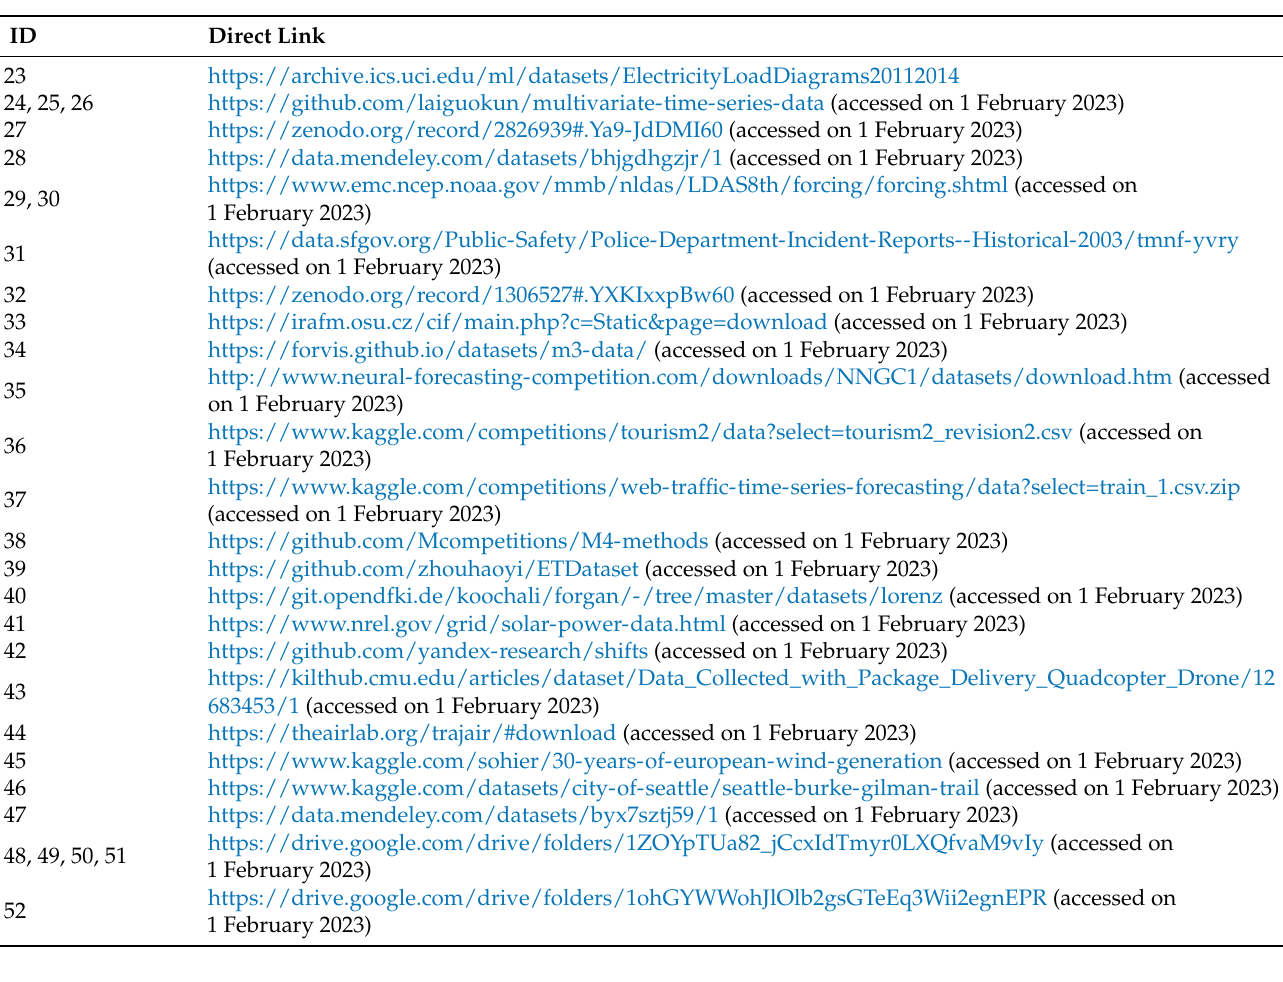
Table 4. A general overview of the public datasets found through the paper screening of “Web of Science”and the “papers with code” as defined in Section 3.1. The coding of the col- umn “Data Structure” column is defined in Table 5 with the underlying structure ( FileDatastruc- ture/DatasetDescription/Timestamp